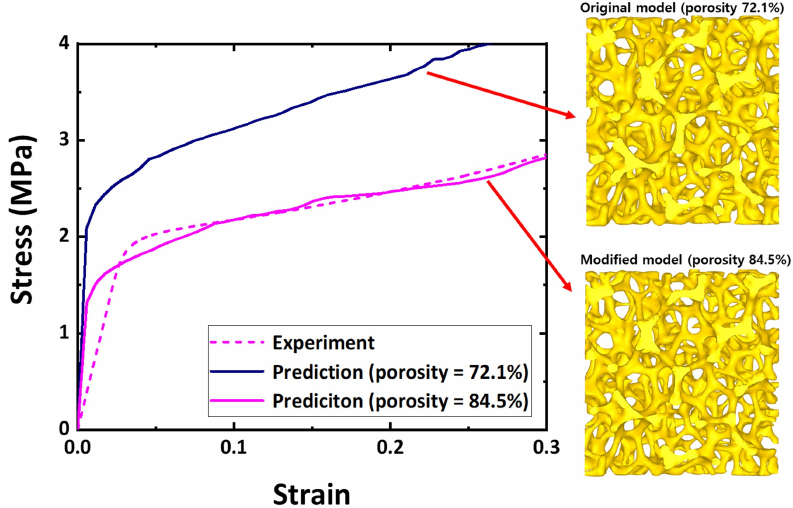
Figure 6. Effect of porosity change on predicted flow behaviors of Specimen 3 during compression. Figure 6: Effect of porosity change on predicted flow behaviors of Specimen 3 during com- pression Based on the flow curves, it is found that the flow stress of Ni foams increases as the porosity level decreases. Porosity is the most dominant factor determining the flow stress. Ni foams with low porosities (Specimens 2 and 3) show a gradual increase in the quasi-plateau stage. The plateau stress of Ni foams with a greater porosity (Specimen